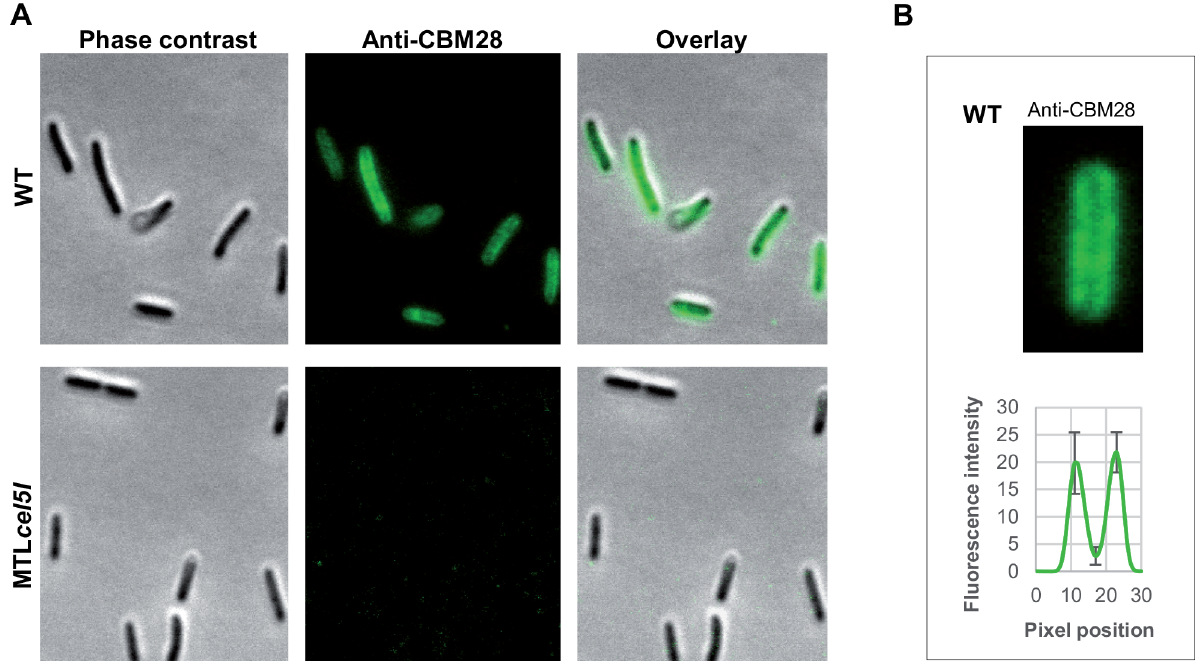
Fig 6. Immunolocalization of Cel5I in R . cellulolyticum strains. A . Cel5I localization was analyzed by fluorescent microcopy on wild- type and MTL cel5I cells. Cells were grown on cellobiose and probed with anti-CBM28 serum, and then anti-Rabbit IgG, Hilyte Fluor Tm 488-labeled. Phase contrast and fluorescence images were taken and overlaid. B. Representative cell fluorescence image, and analysis of fluorescence intensity through the cell body. The graph represents the mean of ten cells.